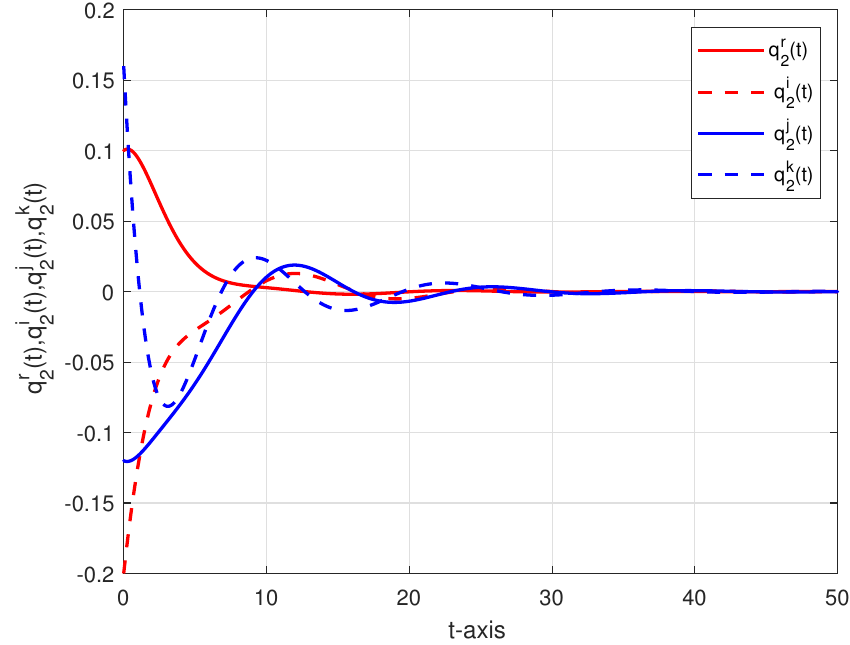
Figure 4. State trajectory of four parts of q 2 ( t ) for system